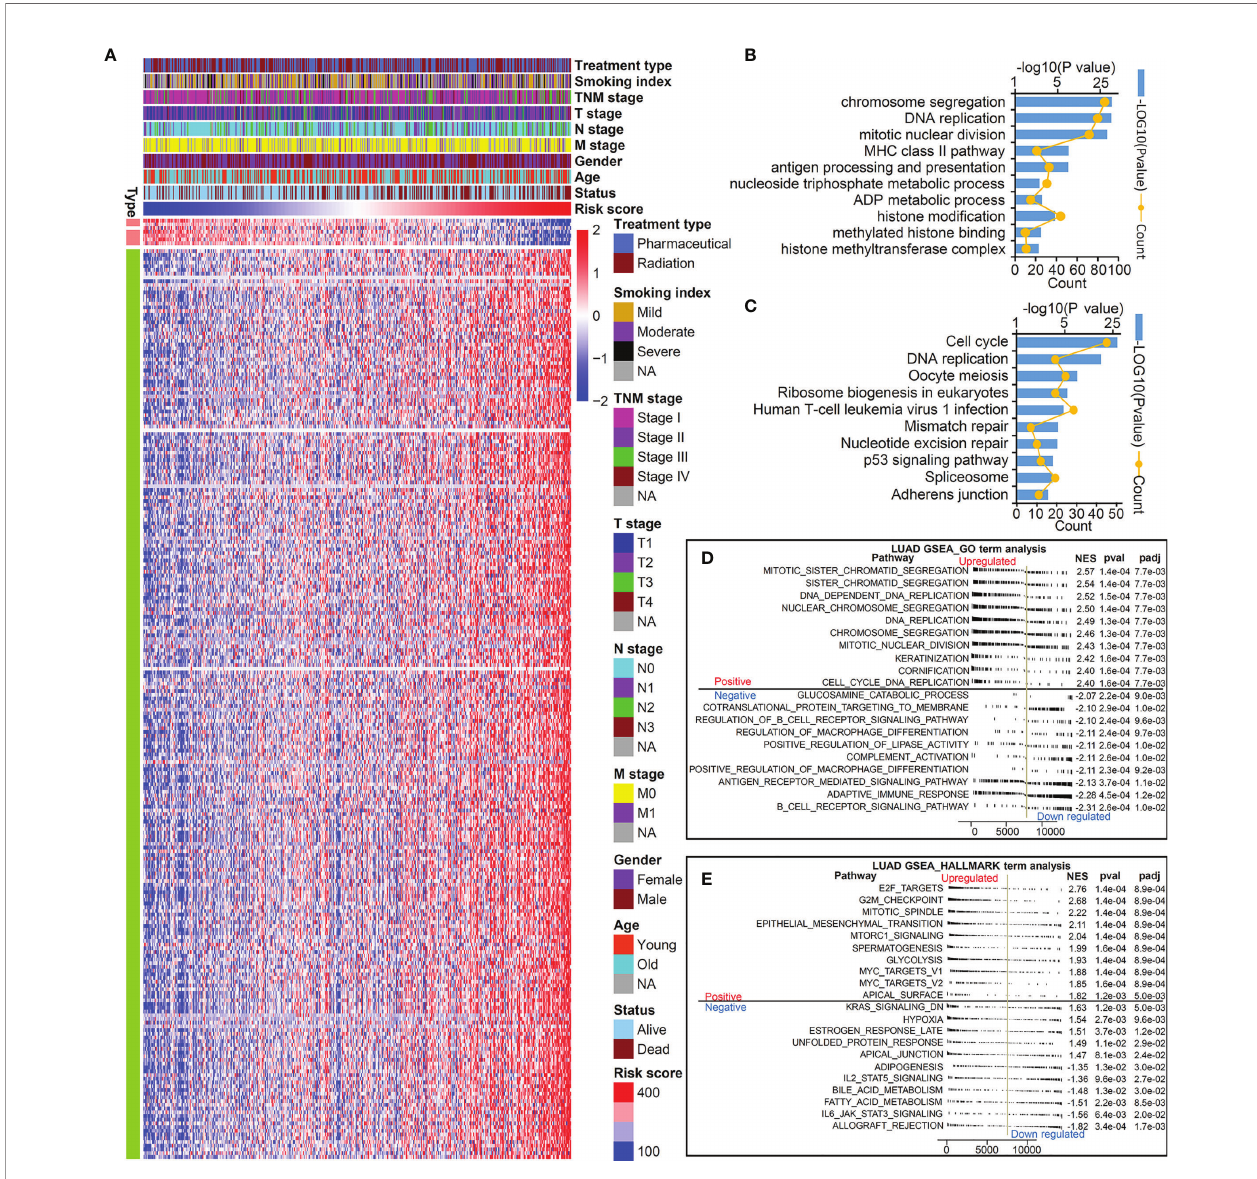
FIGURE 4 | TMEM signature-related genes and pathways. (A) Heatmap of 251 genes signi fi cant correlated to risk score (|r|>4, P<0.05). KEGG (B) and GO (C) analysis of 1,030 genes correlated to risk score (|r|>0, P<0.05). GSEA GO term analysis (D) and hallmark term analysis (E) to compare the different enriched pathways between high-risk group and low-risk